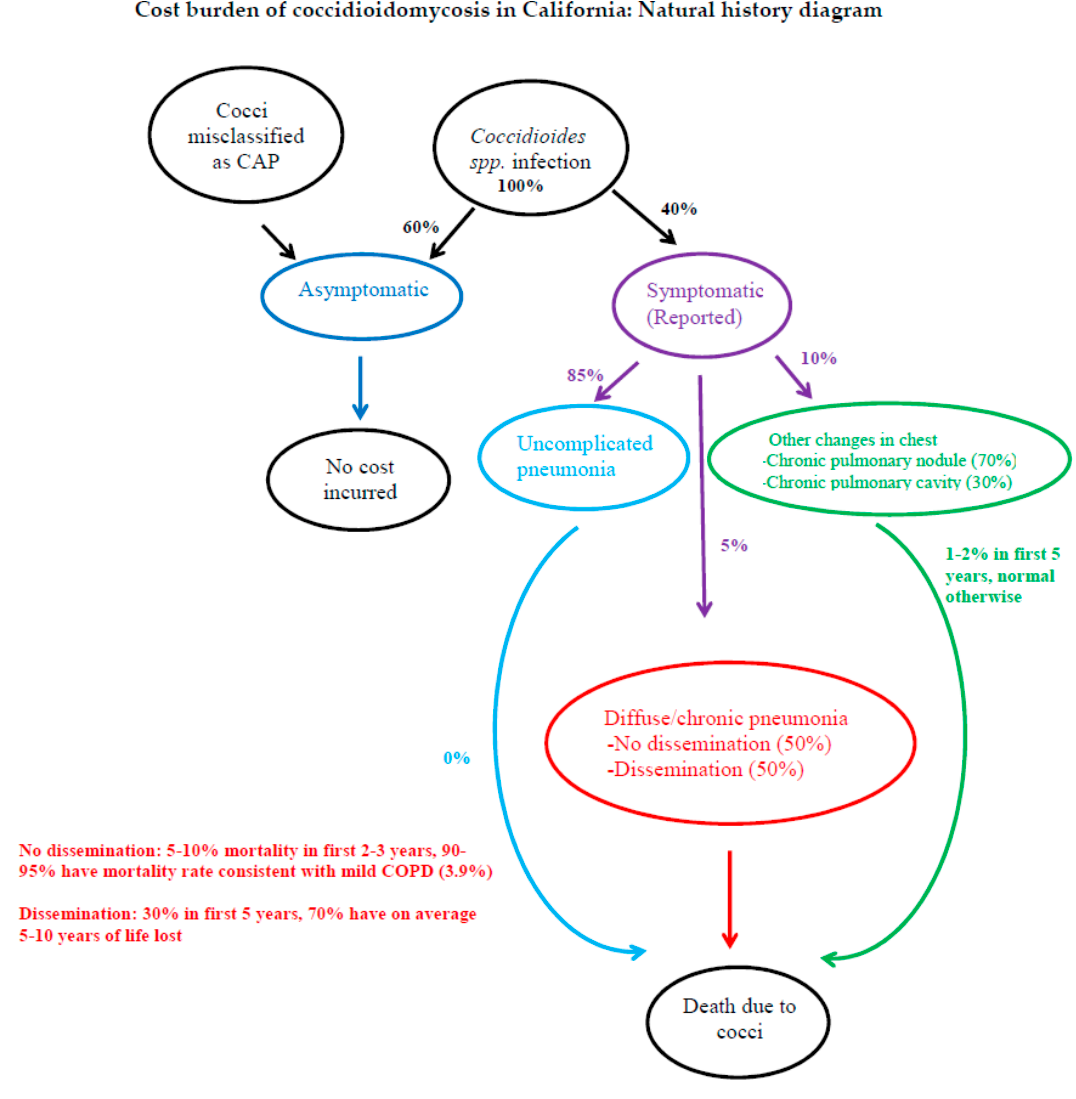
Figure 1. Coccidioidomycosis natural history. CAP = community-acquired pneumonia; spp = forma specialis.